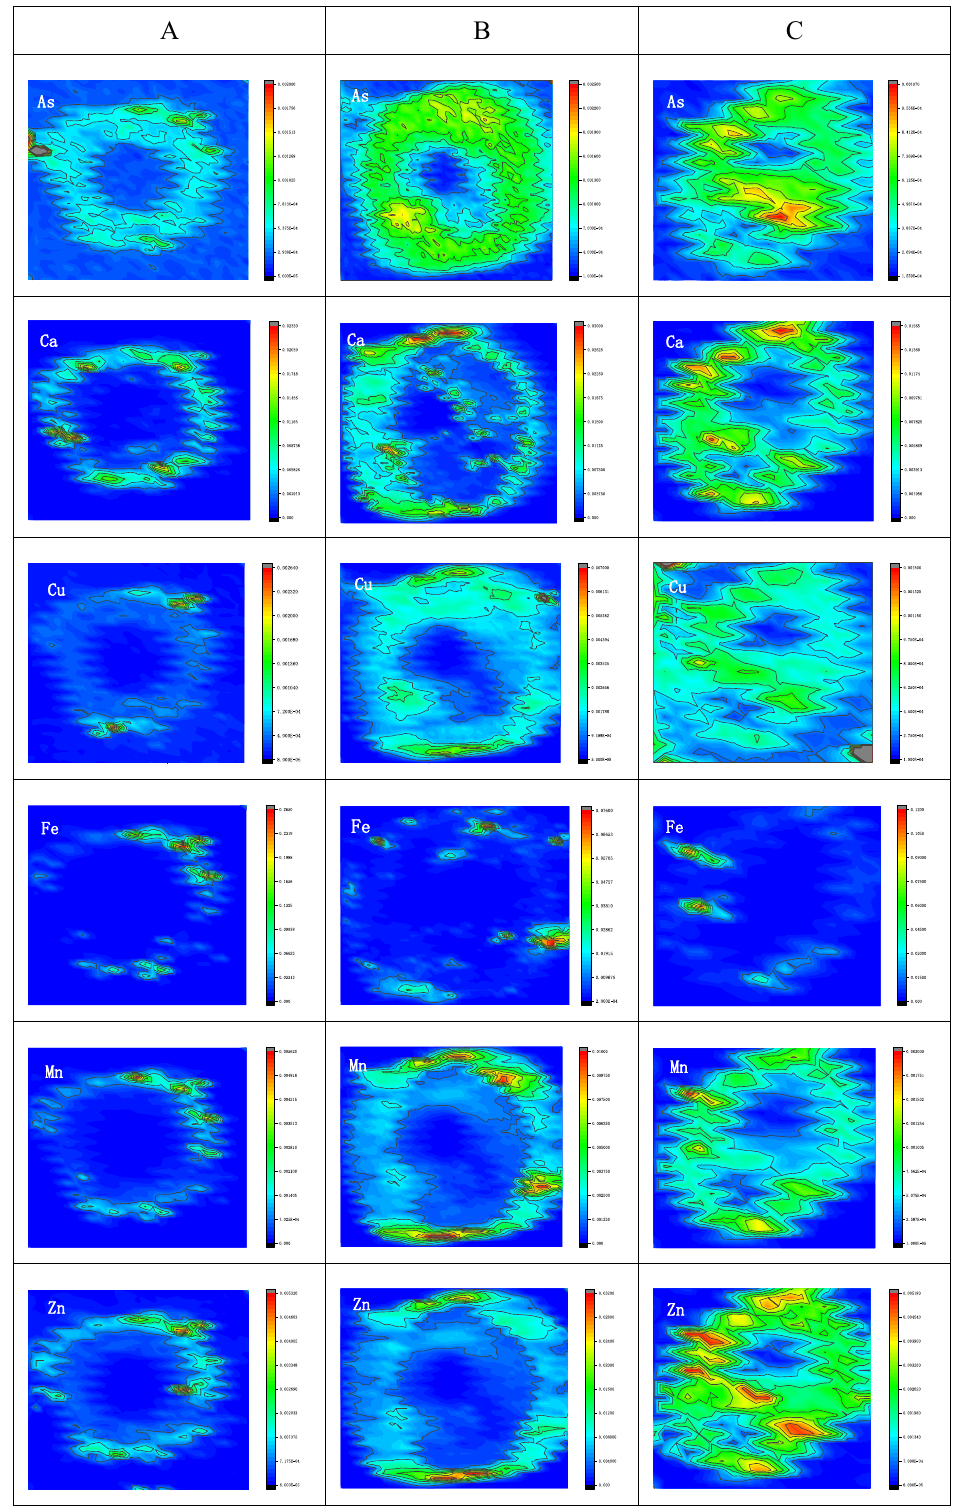
Figure 2: Honeysuckle stem As and other related element μ - XRF distribution. ( A ) 70 mg/L DMA group, ( B ) control group, and ( C ) 30 mg/L As ( III )